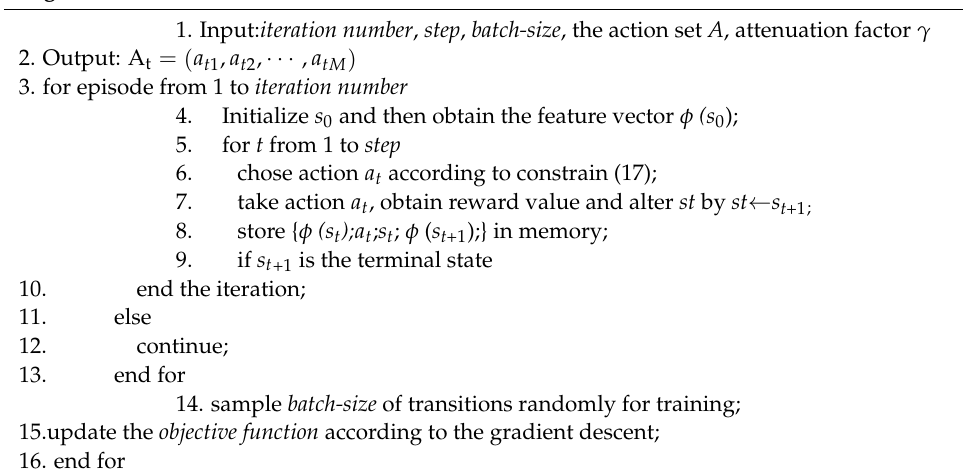
Algorithm 1: Task Performer Allocation Based on